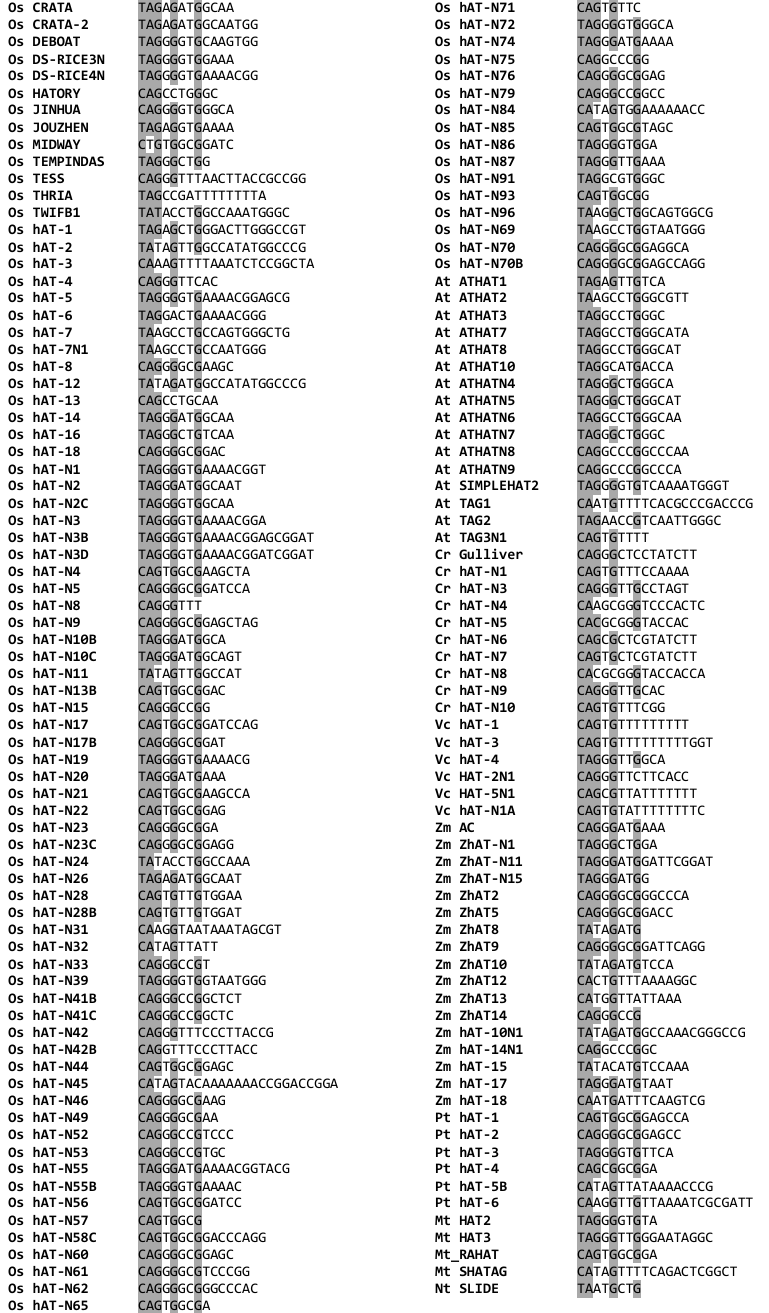
Figure 3. Alignment of the putative terminal inverted repeats (TIR) sequences flanking the plant hAT sequences. The conserved nucleotides are highlighted in grey.